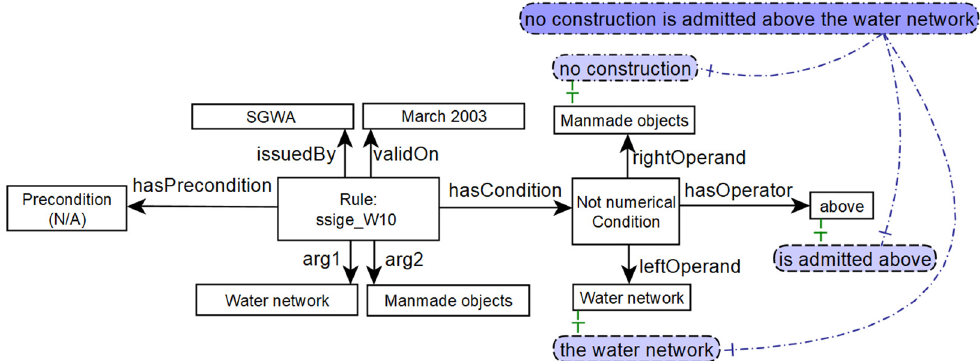
Figure 4. SGWA W 10 rule to manage the spatial interaction between the water network and Figure 4. SGWA W 1 0 rule to manage the spatial interaction between the water network and manmade objects, adapted manmade objects, adapted from [24,25]. from [24,25].